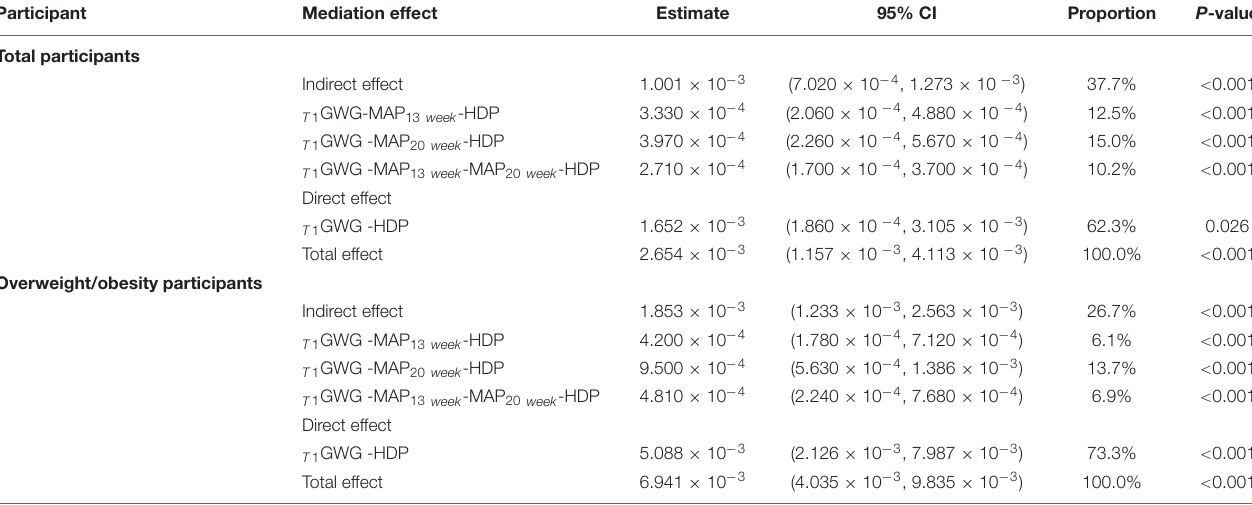
TABLE 3 | Mediation effect of mean arterial pressure (MAP) to the association between the T 1 GWG and HDP.